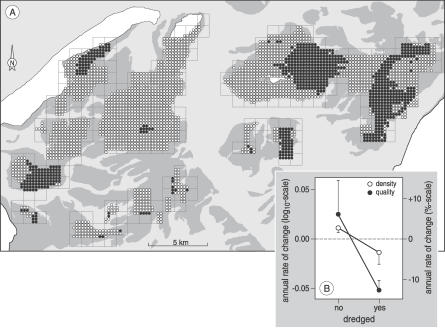
Study Area and Effects of Dredging(A) Map of the study area with 2,846 sampling stations (dots) categorized into 272 square kilometer blocks (squares containing 16 stations at most). A dot is filled when a station has been dredged at least once in 1998–2002 and is open when the station was never dredged during that period.(B) Densities of available cockles remained stable in dredged blocks, but they increased (+3% y−1) in undredged blocks (open dots ± SE bars). Quality of available cockles declined in dredged areas (−11% y−1), whereas it remained stable in undredged areas (filled dots ± SE bars).